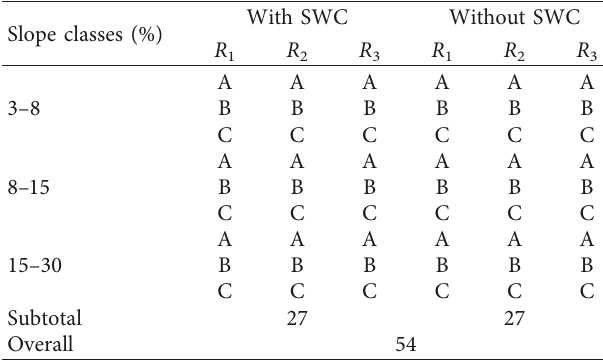
Table 2: Soil sampling design in farmlands with SWC and without SWC